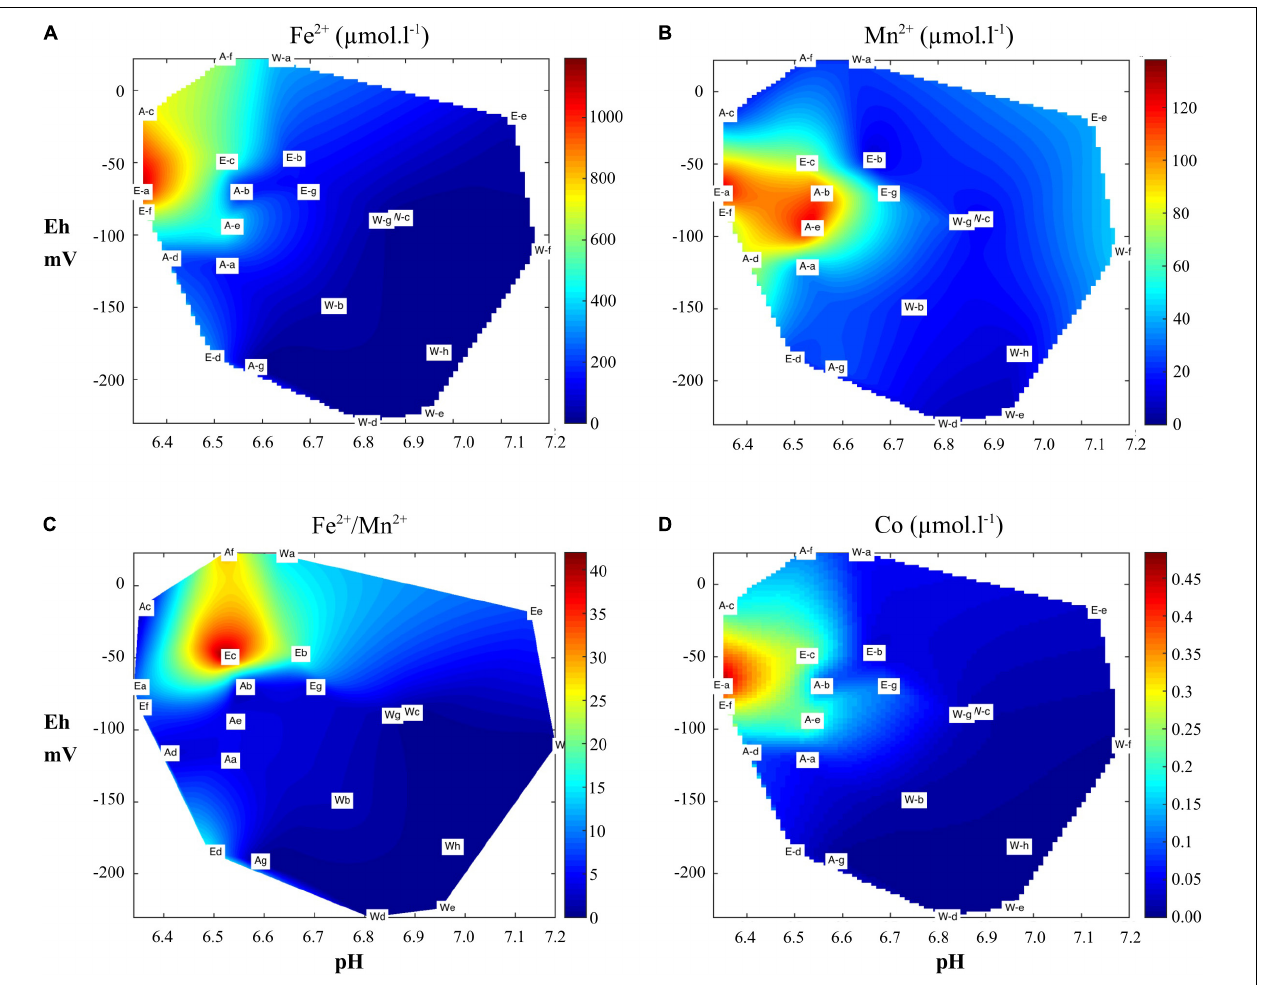
FIGURE 4 | Redox distribution (Eh) of (A) Fe 2 + , (B) Mn 2 + , (D) Co 2 + concentrations, and (C) Fe 2 + /Mn 2 + ratio in relation to the pH as observed in the three ponds in the first cm of